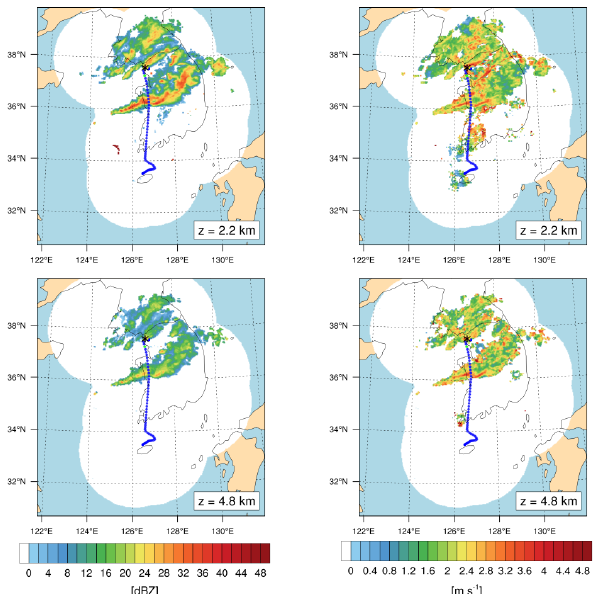
Figure 5. (Left) Horizontal radar reflectivity and (right) spectral width (SW; right) at altitudes of (top) 2.2 and (bottom) 4.8 km at 05:40 UTC 28 October 2018. The location of the turbulence encounter is depicted as a black asterisk and the flight routes are indicated as a dotted line according to the observed in situ EDR values (blue: NIL, green: LGT, yellow: MOD, and pink: SEV, based on [3,27,37,41]).